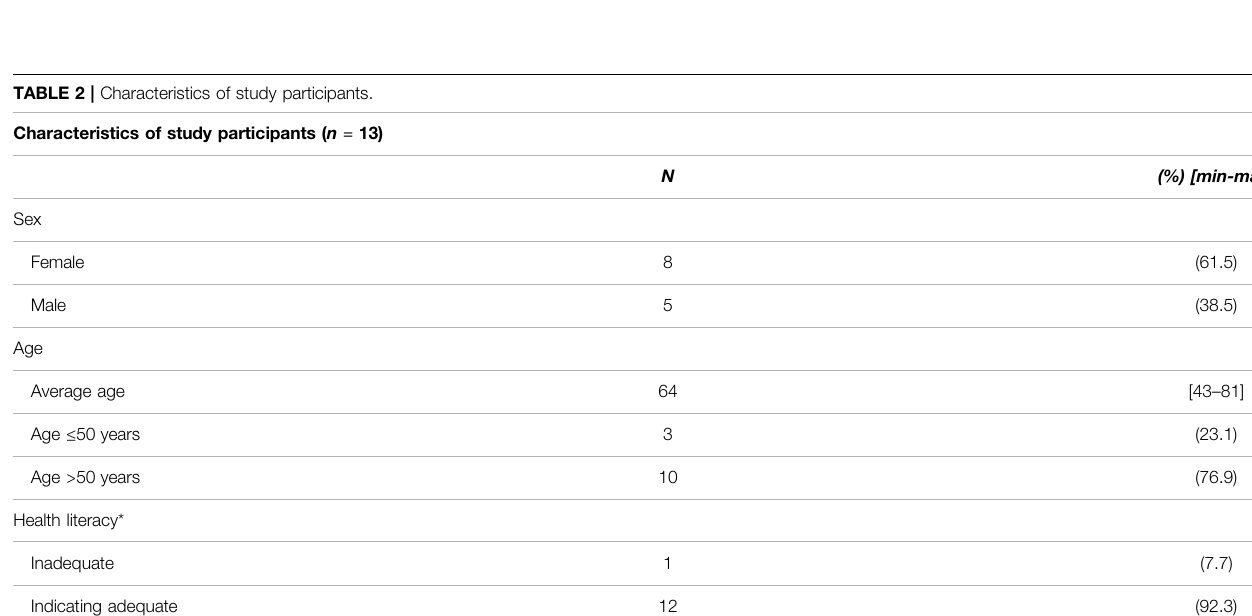
FIGURE 1 | Study fl ow diagram of the recruitment progress.